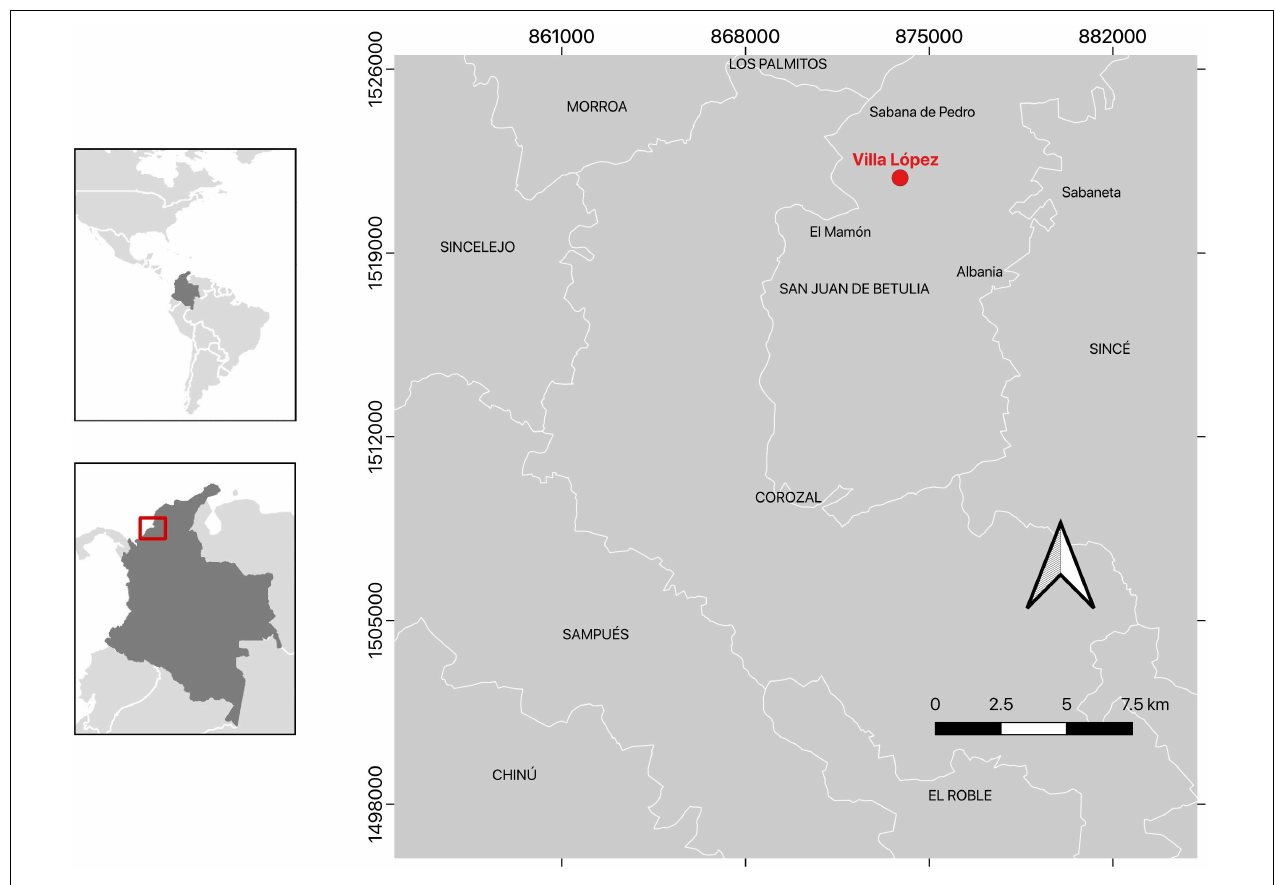
FIGURE 1 | Location of the village Villa López in the Caribbean region, Colombia, and of the localities mentioned in the text. WGS 84.